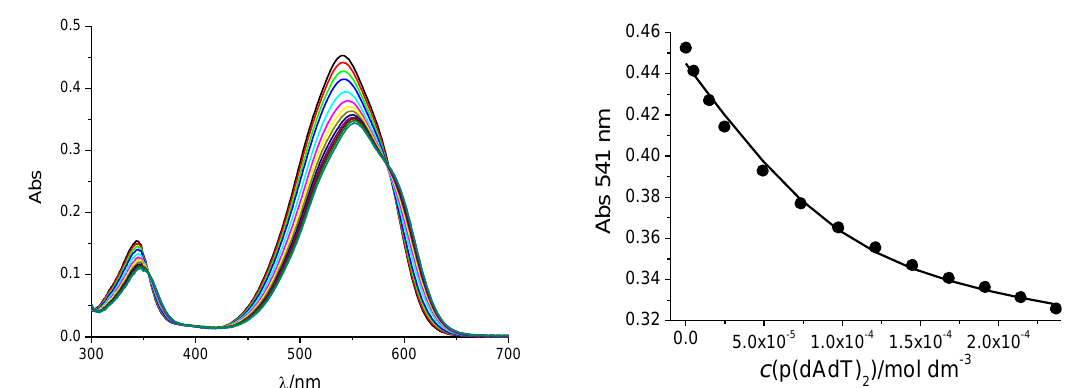
Figure 1. Changes in UV / Vis spectrum of compound F1 ( c = 1 × 10 − 5 mol · dm − 3 ) upon titration with poly dAdT–poly dAdT (LEFT) and dependence of absorbance at λ max = 541 nm on (poly dAdT–poly dAdT), pH 5.0, sodium cacodylate bu ff er, I = 0.05 mol · dm − 3 (RIGHT). The fitting to the Scatchard eq [29,30] (-) yielded parameters shown in Table 2.